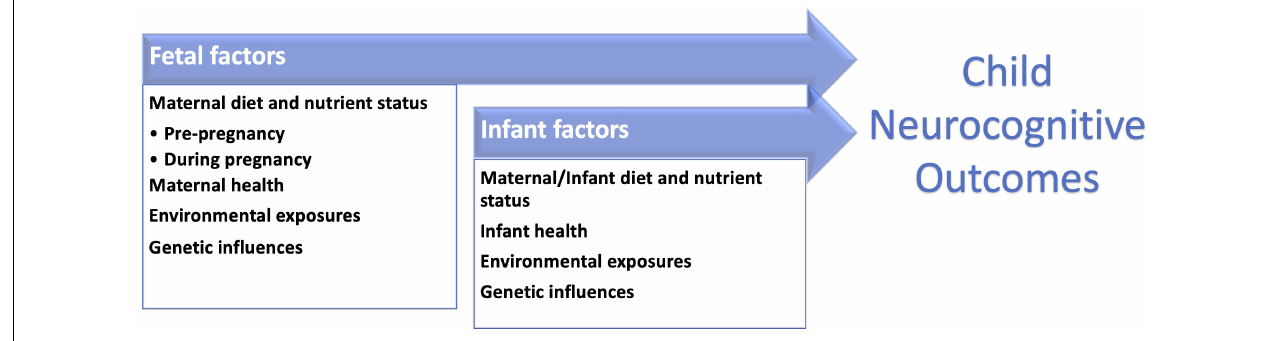
FIGURE 1 | Neurodevelopmental outcomes in childhood are influenced by multiple factors including those present in the prenatal period and infant stages.